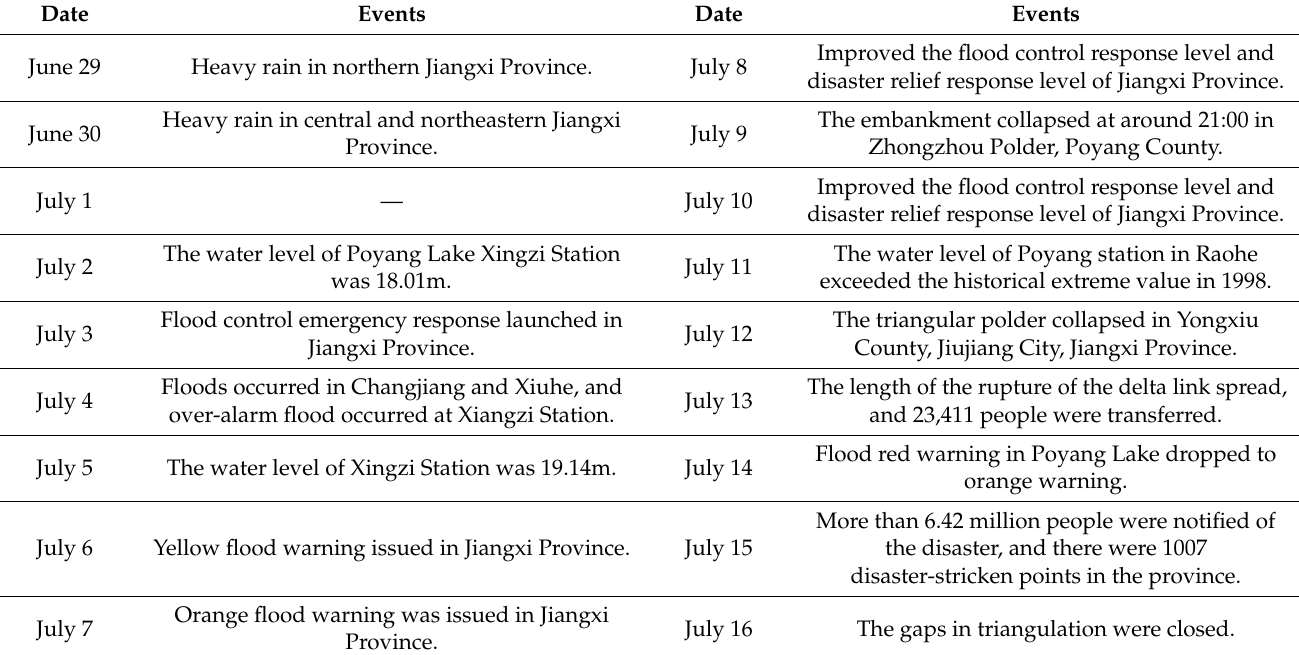
Table 5. Review of Poyang Lake flood